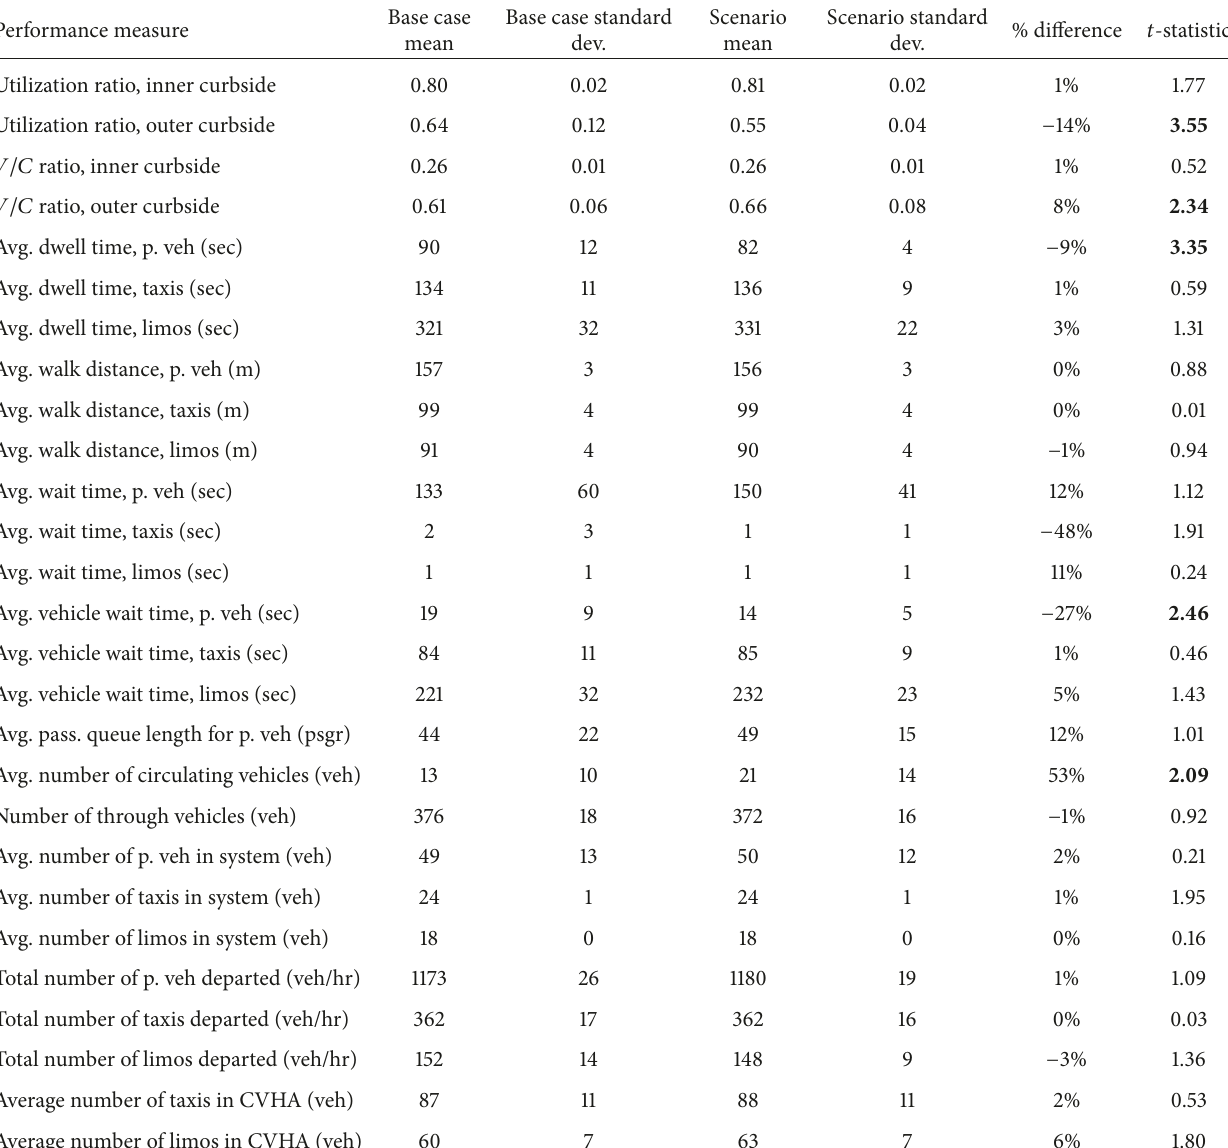
Table 5: Results for double parking scenario (bold cells indicate that result is significantly different from the base